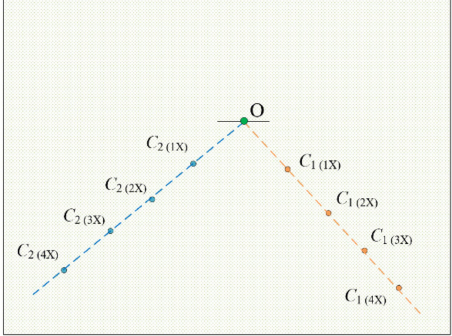
Figure 11. Illustration of finding the principal point O.